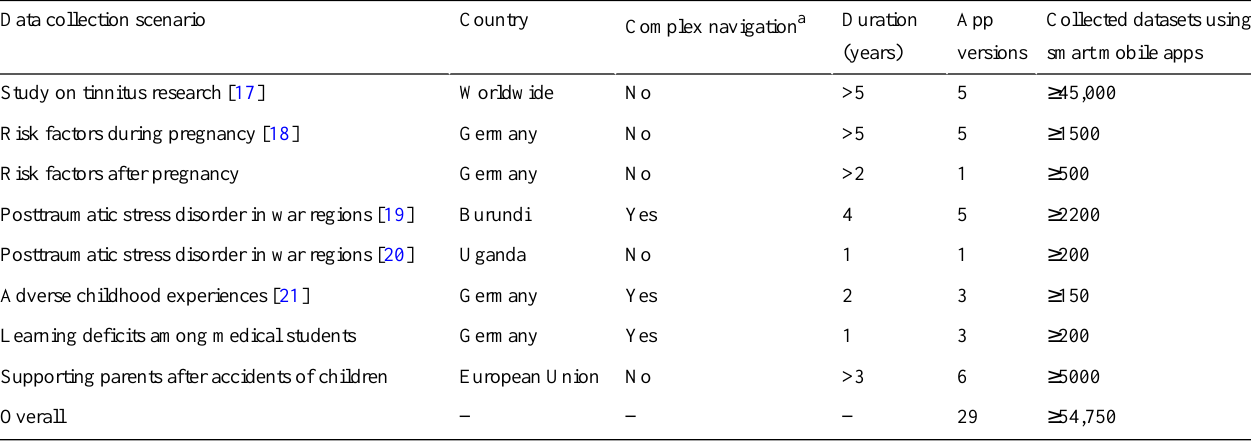
Table 1. Implemented mobile data collection